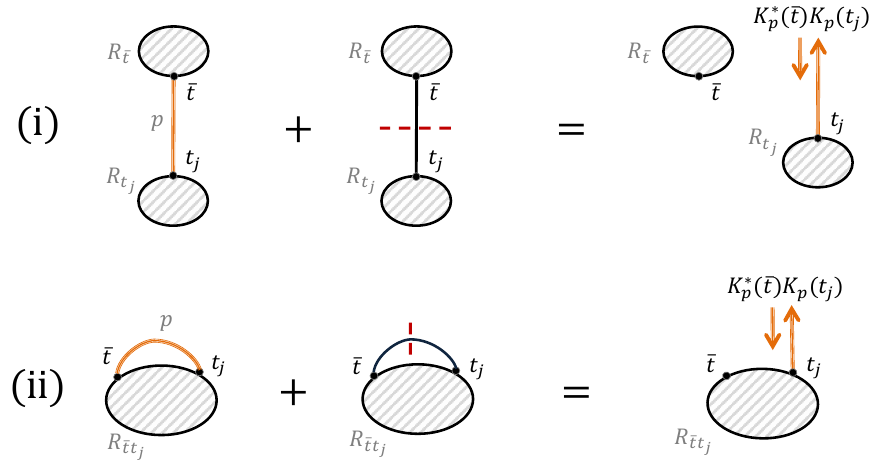
Figure 3 . An internal line between the largest time vertex ¯ t and another time t j is either (i) connecting two otherwise disconnected components, or (ii) forming part of a loop (such that the graph remains connected once it is removed). The pairwise additions shown correspond to (4.9) and (4.9)